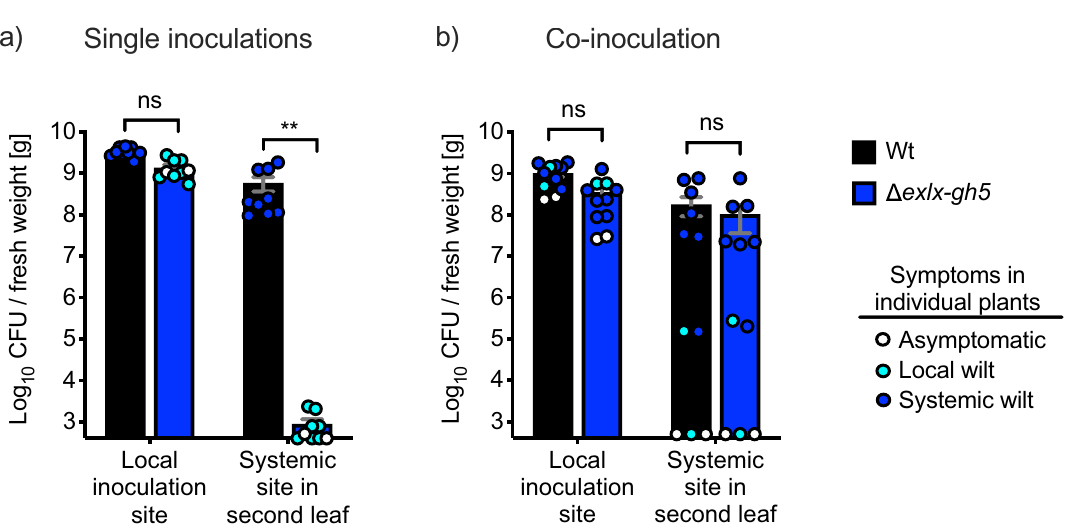
Figure 6. Colonization of Wt and Δ exlx–gh5 strains in plant xylem. ( a ) Squash seedlings were inoculated with either Wt or Δ exlx–gh5. At 12 days post inoculation (DPI), bacterial concentration was determined in the inoculation site and in a petiole of a second, non-inoculated leaf. (Sample sizes, n = 9 per treatment). ( b ) In trans complementation of Δexlx–gh5 and Wt. Plants were co-inoculated with a 1:1 mix of Wt & Δ exlx–gh5. (Sample sizes, n = 11 per treatment). Y-axis is the log 10 CFU/g fresh weight and is scaled to the lower limit of detection for the assay (log 10 CFU/g fresh weight = 2.6). Bars show mean ± SE, and circles are individual biological replicates. ** P < 0.005; ns petiole of the inoculated leaf and the petiole of a second, non-inoculated leaf. At 12 DPI, all of the plants inocu- lated with the Wt strain were systemically wilting, while plants inoculated with Δexlx–gh5 were either asympto- matic or had wilt symptoms only in the inoculated leaf (Fig. 6a). At the inoculation site of all plants, the Wt and Δexlx–gh5 both reached similar cell counts (> 10 9 CFU/g for Wt, and 10 8 –10 9 CFU/g for Δexlx–gh5 ) (Fig. 6a).